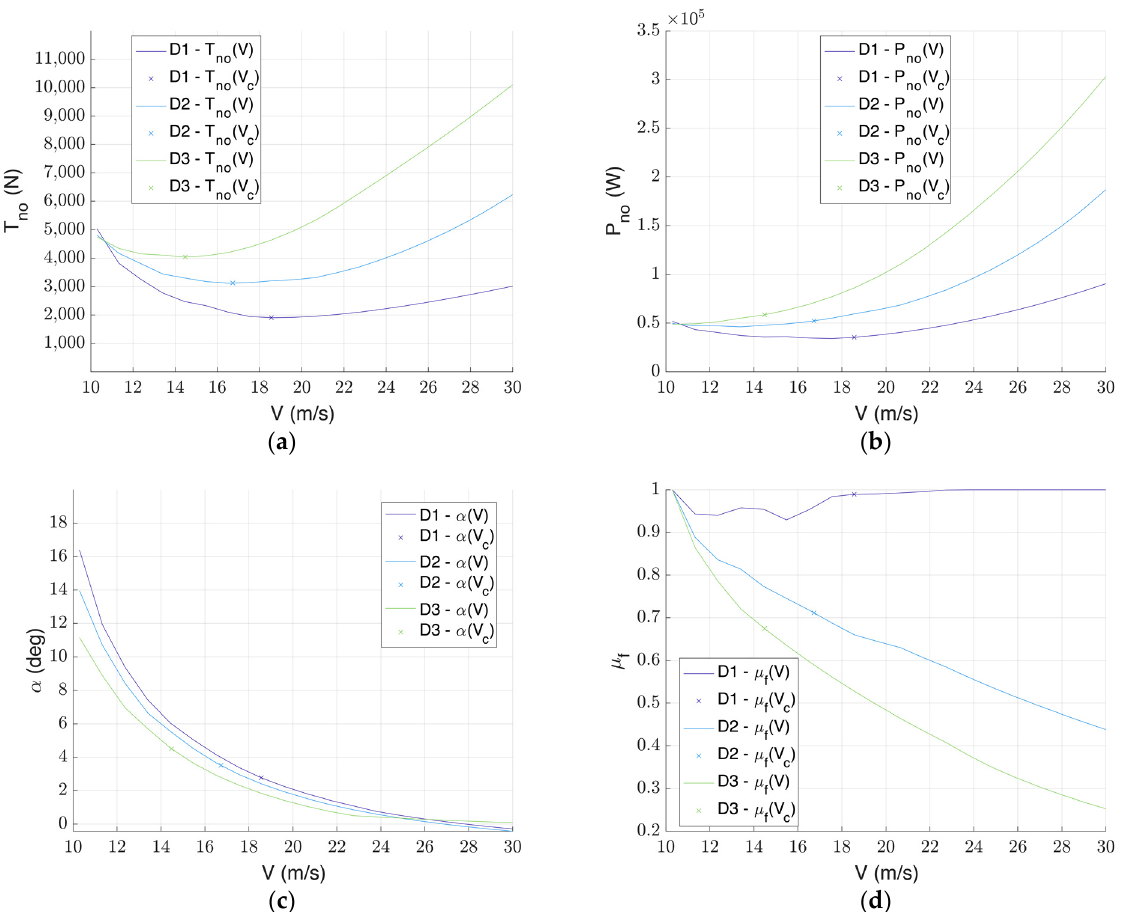
Figure 5. Main parameters of selected configurations as a function of vessel speed: ( a ) minimum thrust, ( b ) minimum power, ( c ) angle of attack, and ( d ) immersion coefficient.